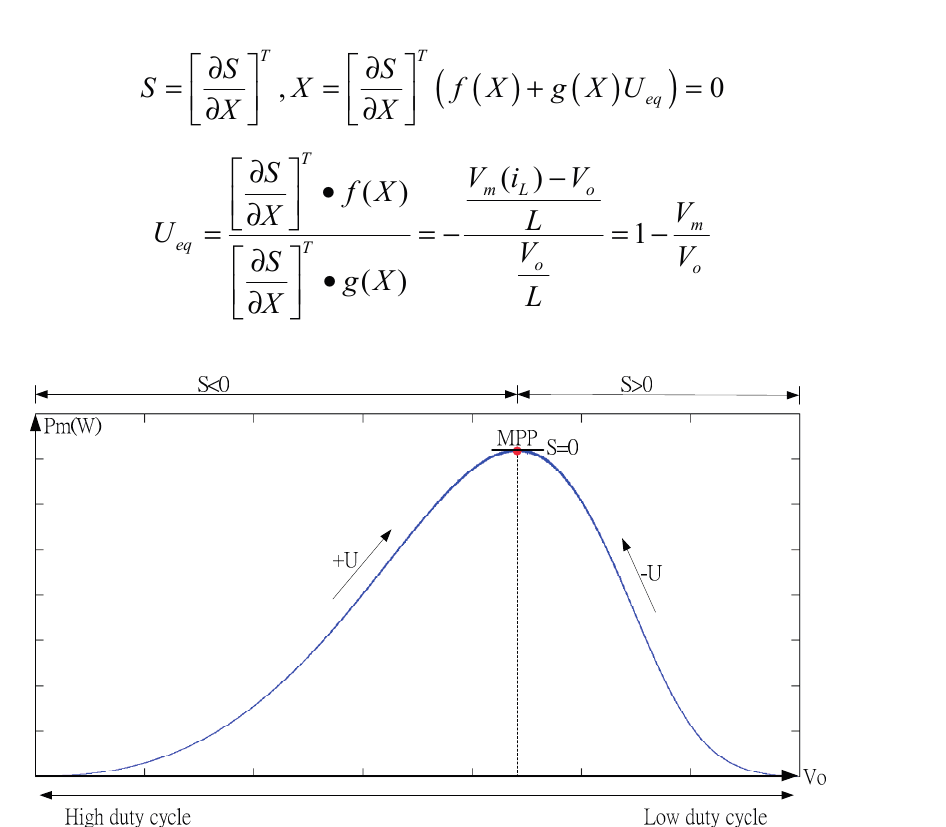
Figure 6. Duty cycle and operating voltage of